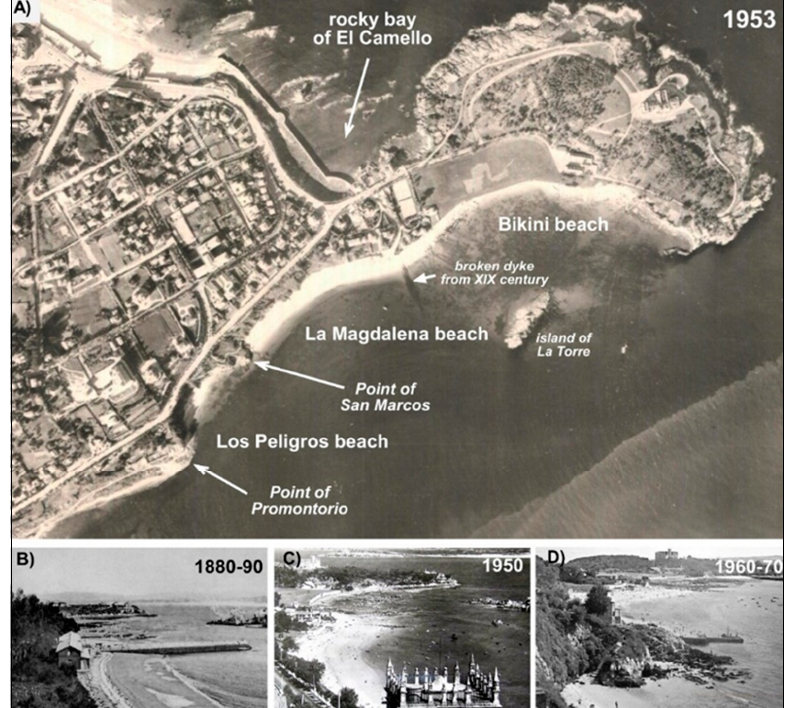
Figure 3. ( A ) Beach area of La Magdalena. Vertical photograph from 1953 (Diputación de Santander). ( B ) Eastern area of La Magdalena with the old sea-spa building and the breakwater (XIX century, now disappeared). ( C ) La Magdalena beach and, in the background, the Bikini beach, with its rocky outcrop at low tide (1950). ( D ) Eastern area of Los Peligros beach in the foreground and the point of San Marcos and the elongated dyke named El Puentuco (old dock), where the eastern side of La Magdalena beach begins (1960–1970).